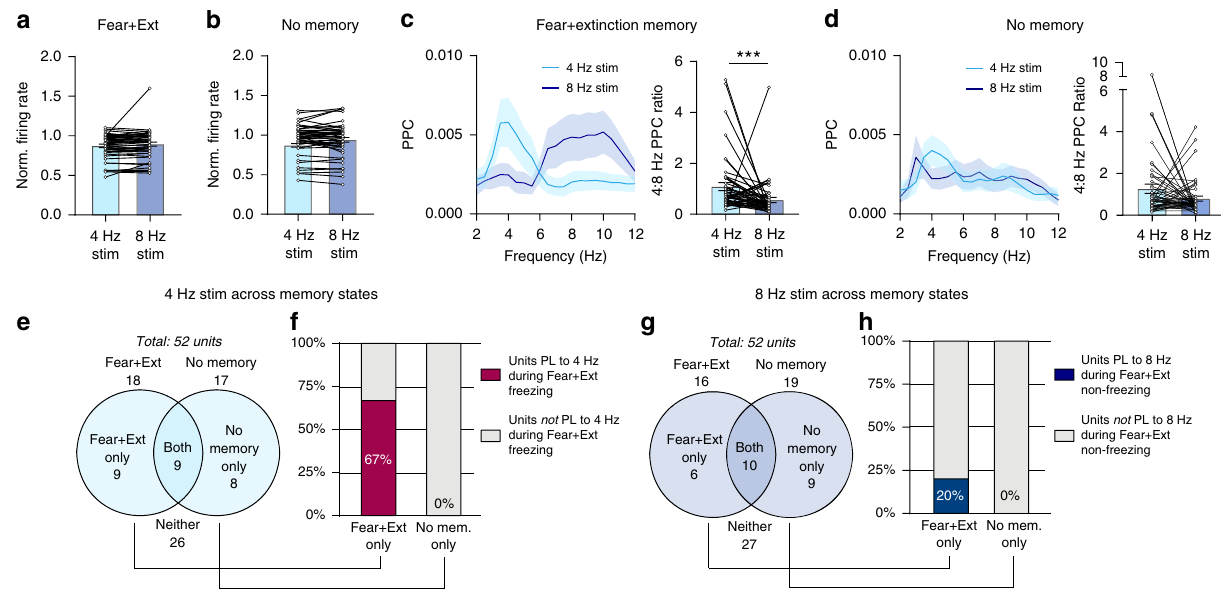
Fig. 4 4 Hz and 8 Hz stimulation differentially synchronizes BLA neurons experience-dependently. a Firing rate of BLA MUA is not signi fi cantly different during 4 Hz and 8 Hz sinusoidal stimulation in the conditioned context ( fi ring rate normalized to no light; paired two-tailed Wilcoxon test: P = 0.22, n = 50 MUA). b Same as in a but in unconditioned context (paired two-tailed Wilcoxon test: P = 0.33, n = 50 MUA). c Averaged PPC spectra (left) of BLA MUA during 4 Hz and 8 Hz optical stimulation in the conditioned context (Fear + Ext memory state). MUA phase-locking quanti fi ed as 4:8 Hz PPC ratio (right) is signi fi cantly shifted by 4 Hz vs. 8 Hz stimulation in the memory-context (paired two-tailed Wilcoxon test: P = 0.0005, n = 50 MUA). d Same as in c but in the unconditioned context (no memory state). MUA phase-locking is not signi fi cantly shifted by 4 Hz vs. 8 Hz stimulation in the unconditioned context (paired two-tailed Wilcoxon test: P = 0.17, n = 50 MUA). e Venn diagram showing the distribution of units signi fi cantly phase-locked to 4 Hz stimulus waveform in the conditioned (Fear + Ext) context (left), unconditioned neutral context (right), or both (middle overlap). f Proportion of units recruited to freezing-associated 4 Hz oscillations in the conditioned context is enriched among units that signi fi cantly phase-lock to 4 Hz stimulation in the conditioned context (Chi-square test: X 2 = 8.24, P = 0.0041, n = 17 units). g Same as e but for 8 Hz stimulation. h Proportion of units recruited to non-freezing- associated 8 Hz oscillations in the conditioned context among units that signi fi cantly phase-lock to 8 Hz stimulation in the conditioned versus unconditioned context (Chi-square test: X 2 = 1.94, P = 0.16, n = 14 units: one of the six Fear + Ext-only units in panel g did not meet the minimum number of spike criterium for PPC analysis during the non-freezing behavioral state). All error bars and shaded area: mean ±